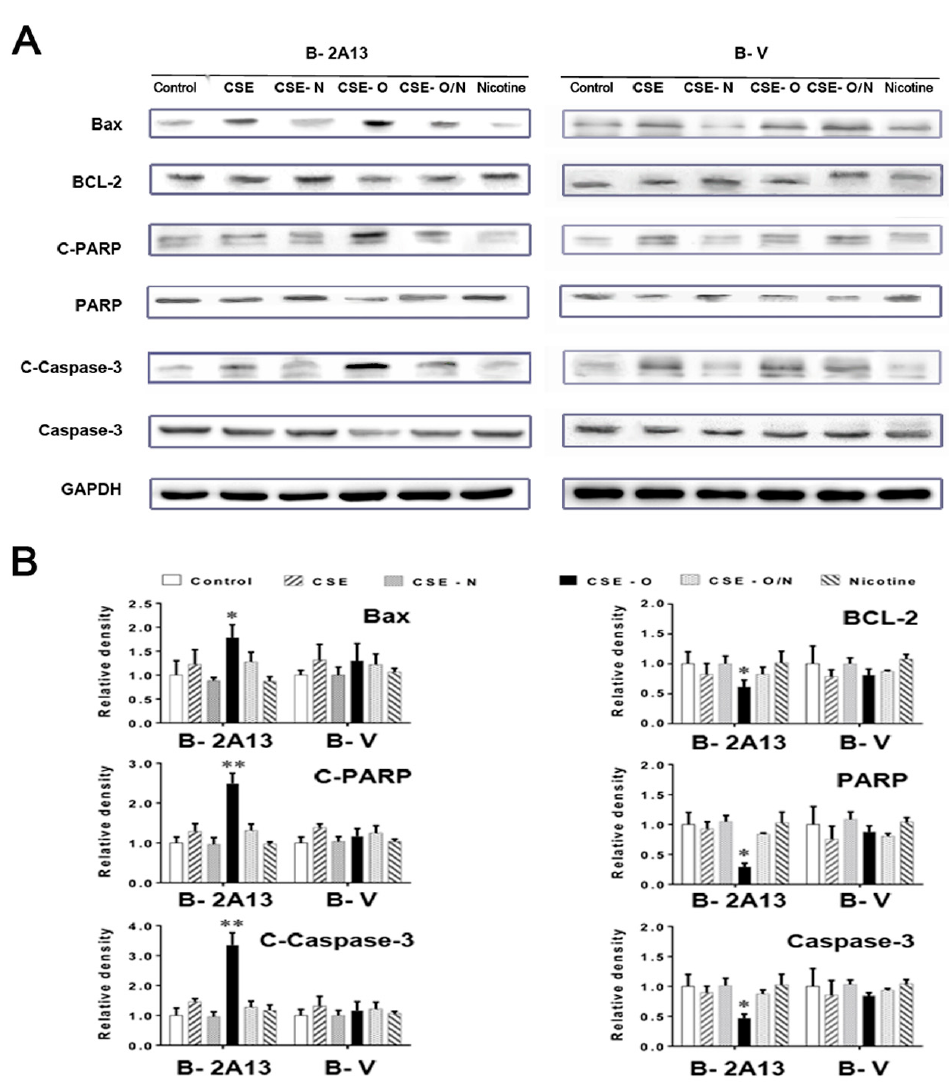
Figure 5. Expression of apoptosis-related proteins in immortalized human bronchial epithelial (BEAS-2B) cells treated with cigarette smoke extract (CSE), nicotine section of CSE (CSE-N) or nicotine-free section of CSE (CSE-O). The cells were treated with 4% CSE, CSE-N, CSE-O, CSE-O/N, or nicotine standard (100 µ M) for 24 h. Cell lysates (50 µ g) were prepared to determine the expression of apoptosis-related proteins by Western blot assay using antibodies specific for B cell lymphoma-2 (Bcl-2), Bcl-2 Associated X Protein (Bax), nuclear enzyme poly polymerase (PARP), cleaved PARP (C-PARP), caspase-3, and C-caspase-3. Glyceraldehyde 3-phosphate dehydrogenase (GAPDH) was used as an internal control. ( A ) Electrophoresis of Western blot. ( B ) Relative density scanned by Image J software using GAPDH as a reference. * p < 0.05; ** p < 0.01, compared to cells treated with CSE or CSE ‐ N.